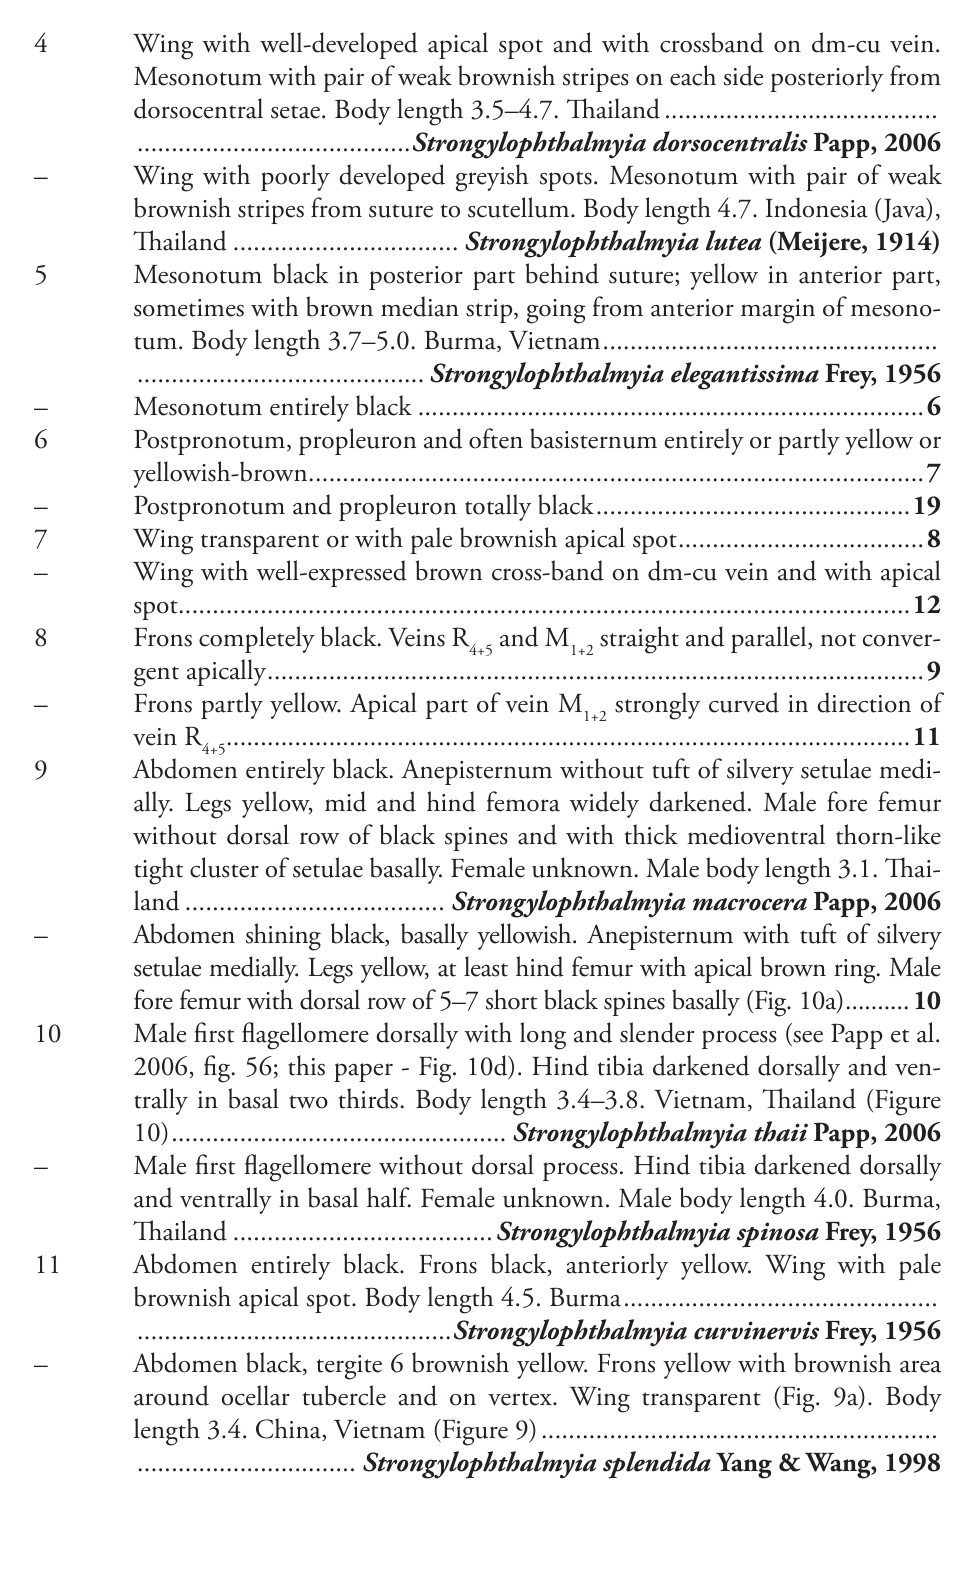
Wing with well-developed apical spot and with crossband on dm-cu vein. Mesonotum with pair of weak brownish stripes on each side posteriorly from dorsocentral setae. Body length 3.5–4.7. Thailand ........................................ – Wing with poorly developed greyish spots. Mesonotum with pair of weak brownish stripes from suture to scutellum. Body length 4.7. Indonesia (Java), 5 Mesonotum black in posterior part behind suture; yellow in anterior part, sometimes with brown median strip, going from anterior margin of mesono-